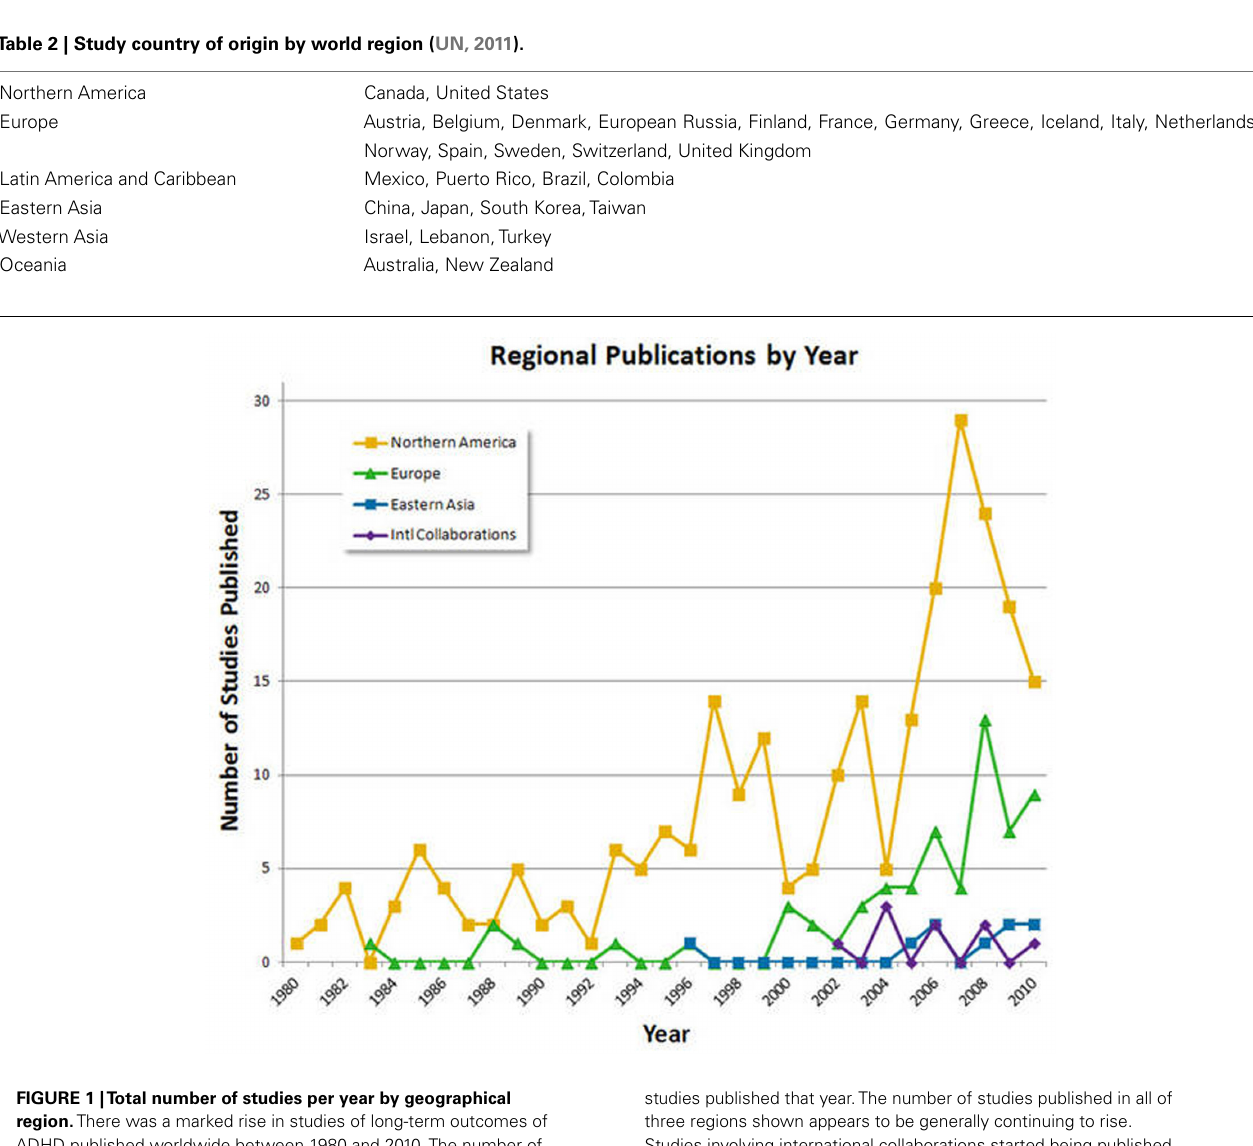
studies published that year.The number of studies published in all of three regions shown appears to be generally continuing to rise. Studies involving international collaborations started being published in